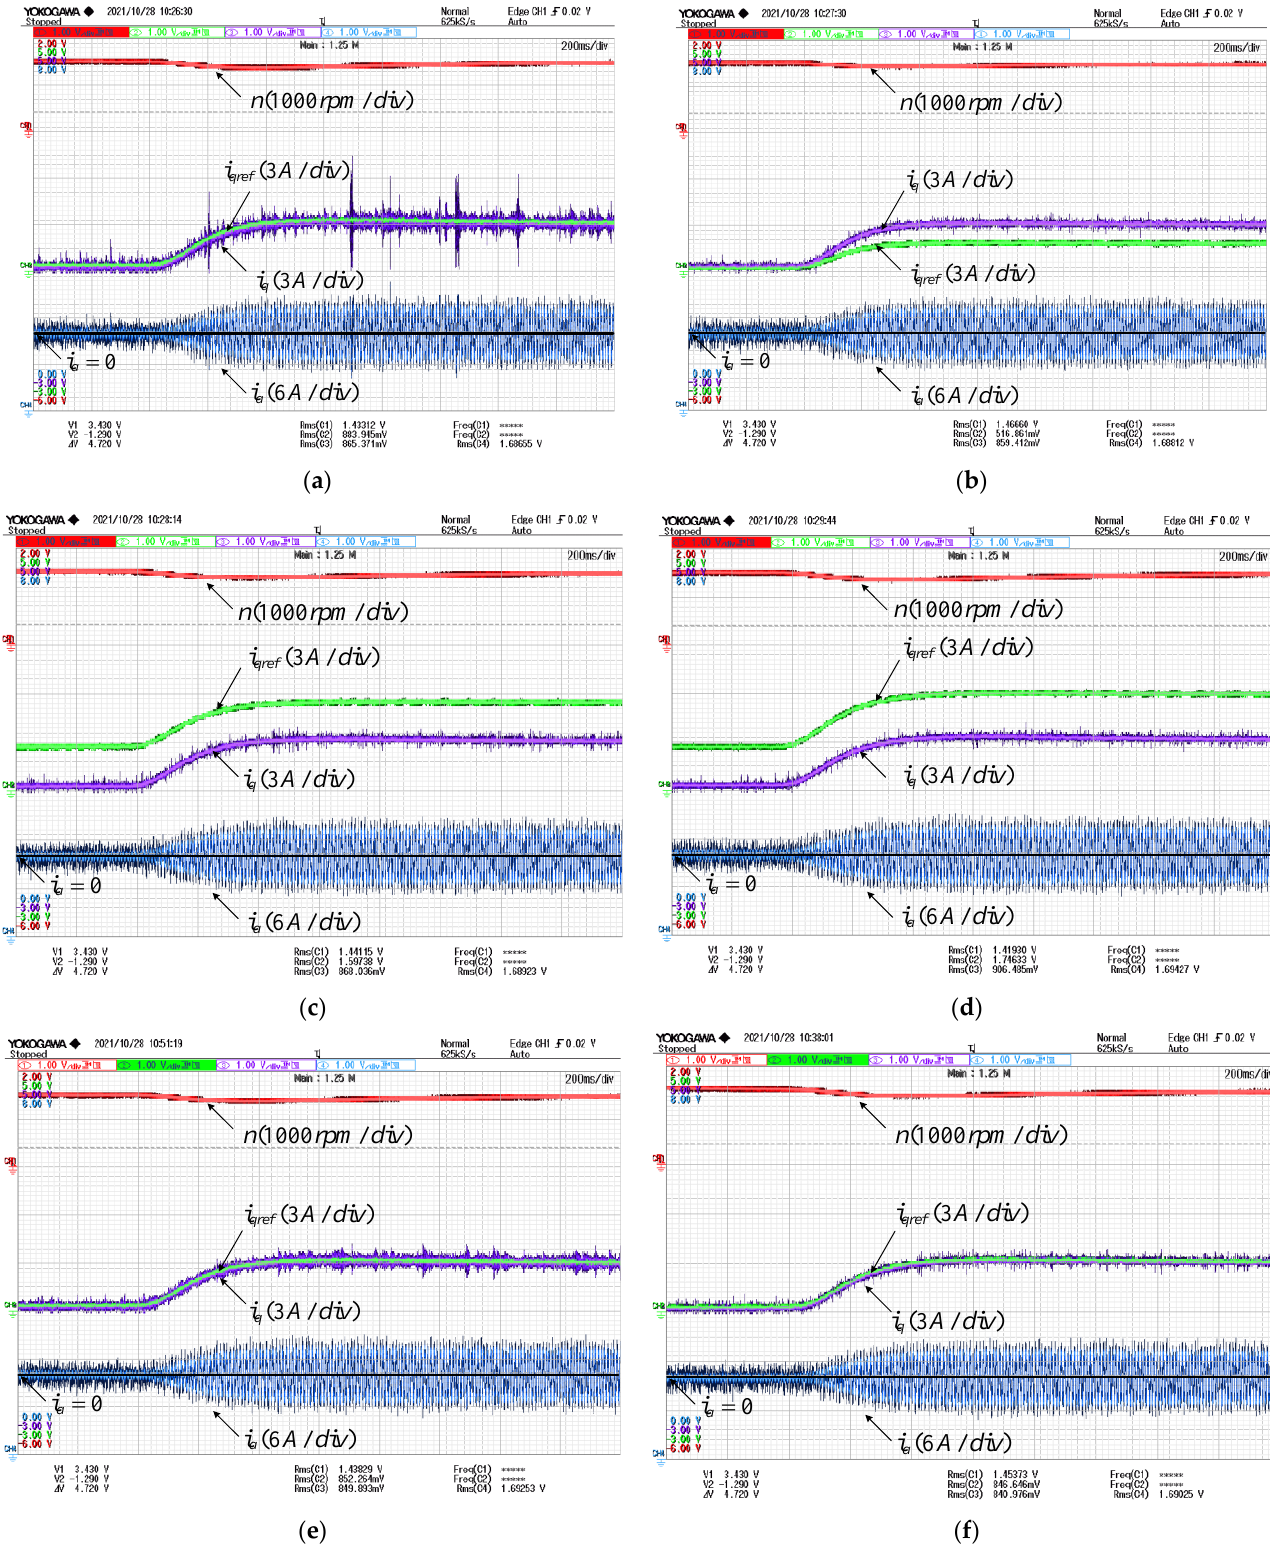
Figure 5. Experiment results of current tracking performance under loads. ( a ) Conventional DBPCC with L 0 = 1.8 L ; ( b ) conventional DBPCC with R 0 = 6 R ; ( c ) conventional DBPCC with ψ f 0 = 0.3 ψ f ; ( d ) conventional DBPCC with L 0 = 0.6 L , R 0 = 0.1 R , ψ f 0 = 0.6 ψ f ; ( e ) PI controller; ( f )